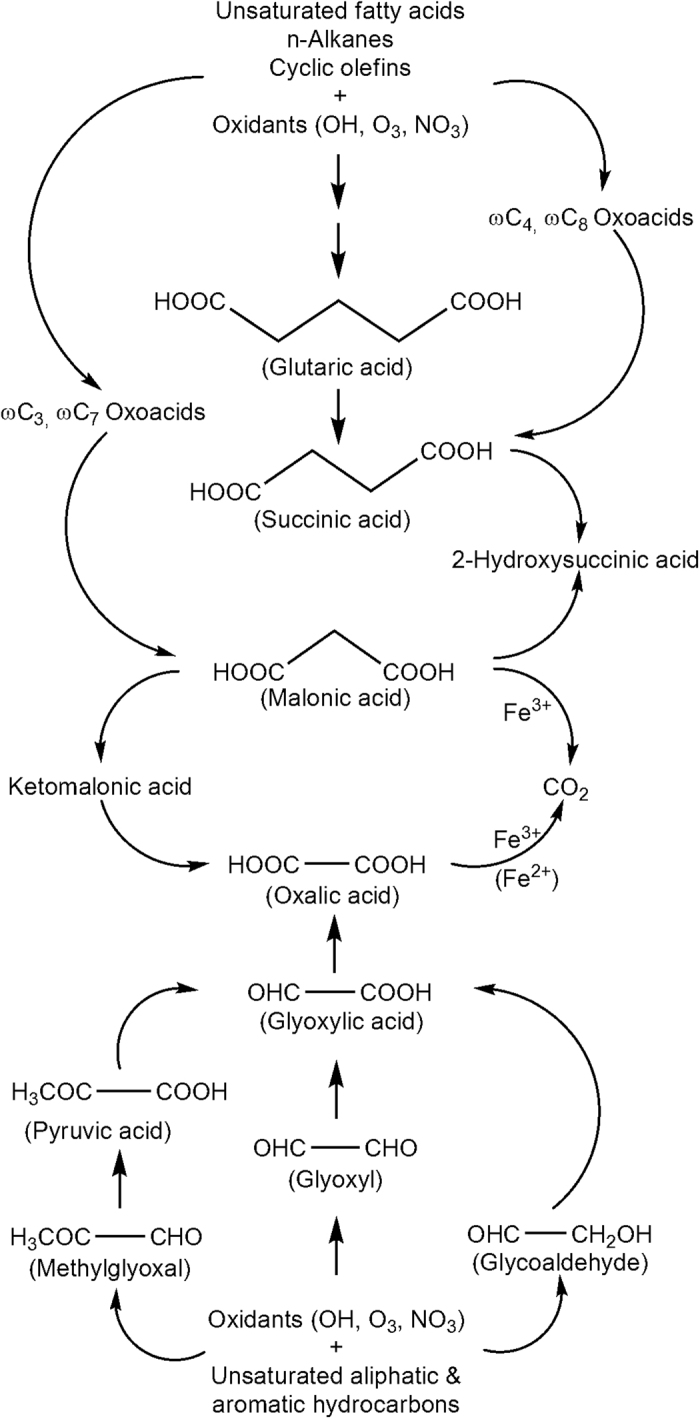
Possible photochemical oxidation pathways of diacids and related compounds in aqueous aerosols14162021272829404142.